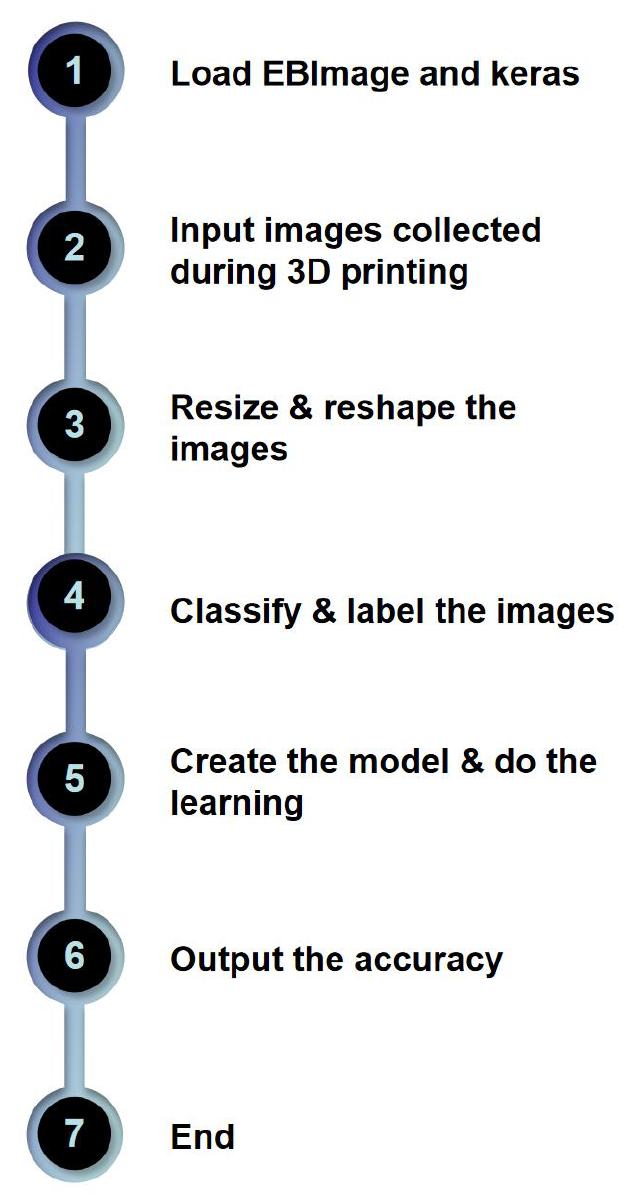
Figure 2. Structure of the code created in this research.